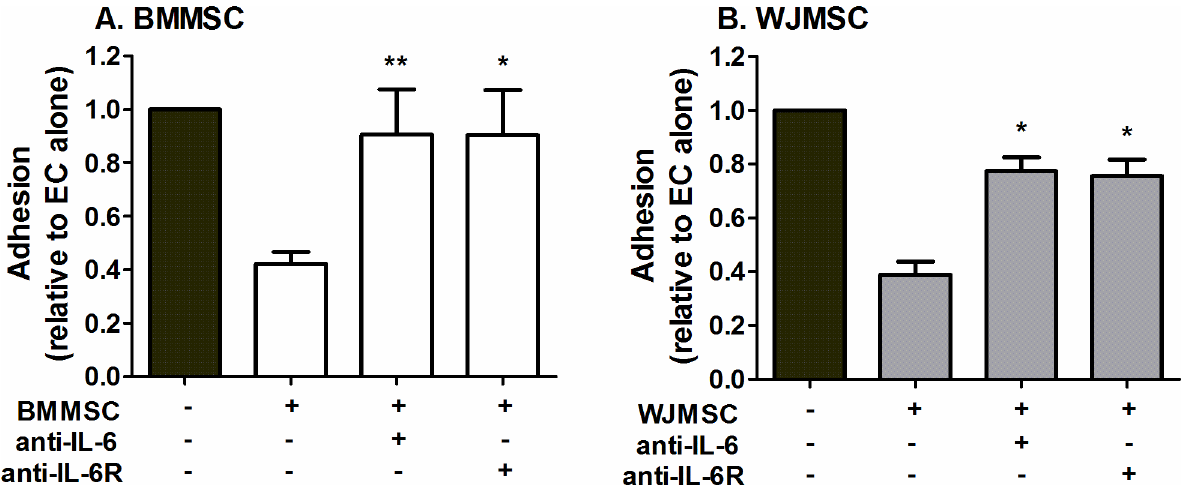
Fig 7. Effect of blocking the actions of IL-6 on the immunosuppressive effects of MSC in co-culture. (A) BMMSC or (B) WJMSC co-cultures were cultured in close proximity, on opposite sides of a porous filters for 24h and then treated with neutralising antibodies against IL-6 or a function blocking antibody against IL-6R for the duration of the co-culture and cytokine treatment. Neutrophil adhesion was expressed as a proportion of that observed on the paired EC mono-culture. ANOVA showed a significant effect of co-culture treatment on neutrophil adhesion in (A) (p < 0.05) and (B) (p < 0.01). Data are mean ± SEM, n = 3 – 4 independent experiments using a different EC and neutrophil donor in each experiment. (A) 3 different BMMSC and (B) 4 different WJMSC donors were used. * = p < 0.05 and ** = p < 0.01 compared to untreated MSC co-cultures by Dunnett